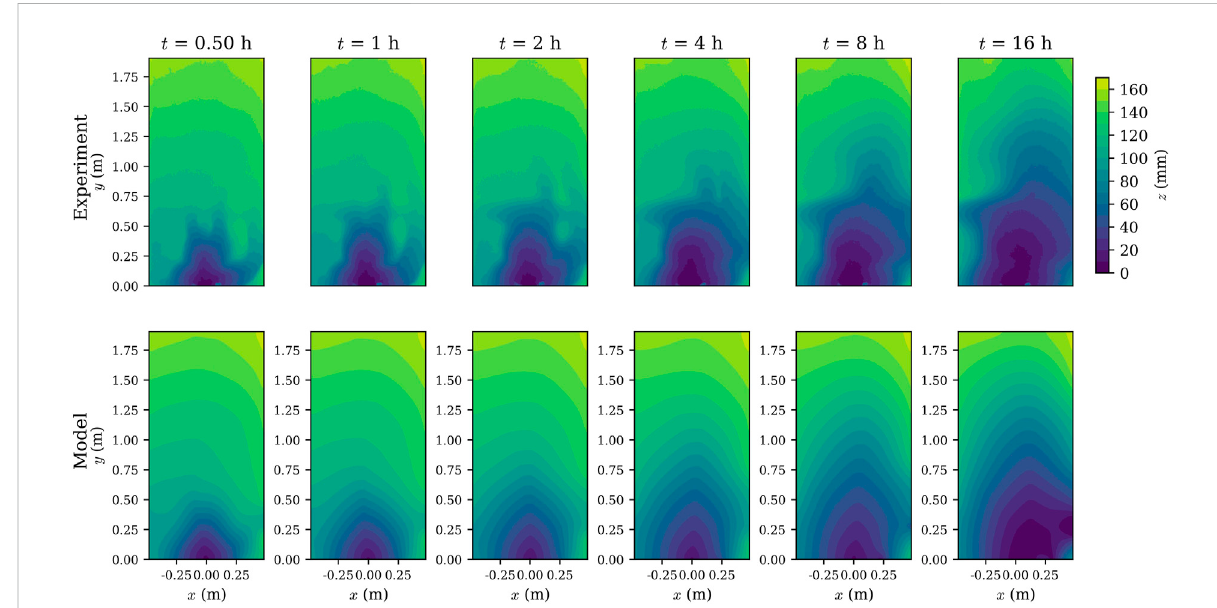
FIGURE 4 Numerical simulation of the LEM and the experimental data. In both experiment and simulation, the morphology evolves toward the high precipitation area.